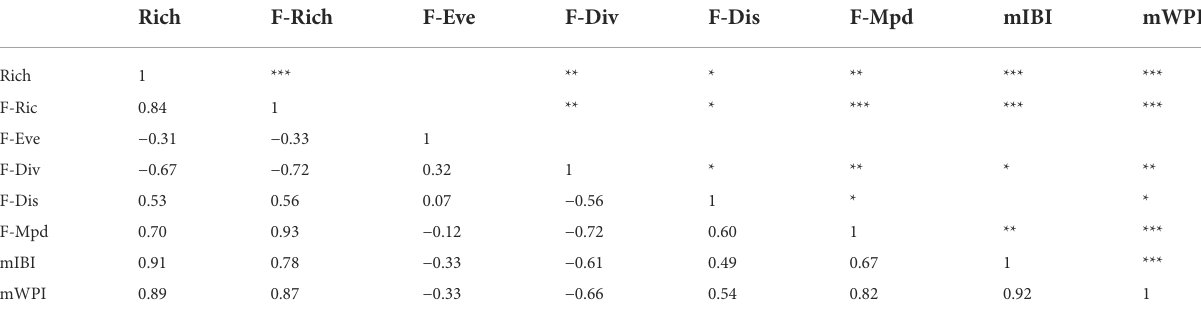
TABLE 4 Correlations among species richness (Rich), functional indices, and river health assessment based mWPI and